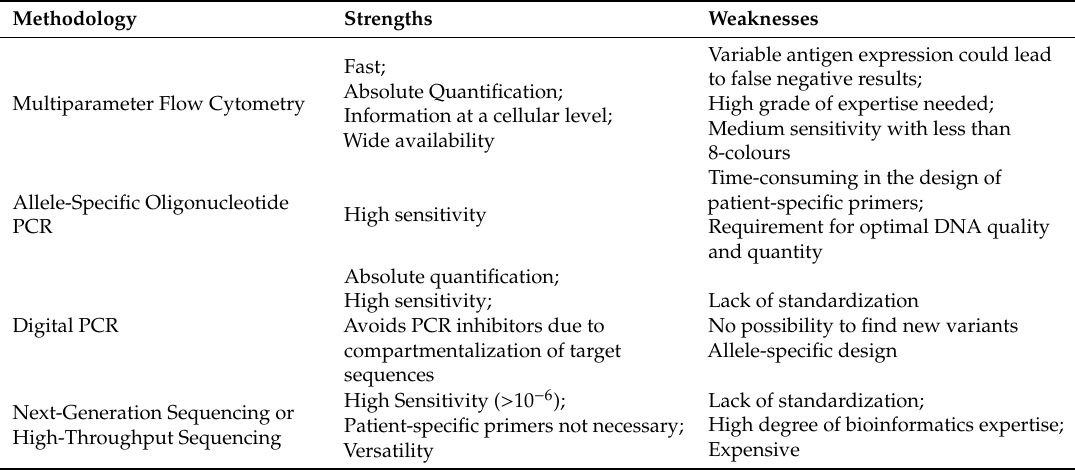
Table 1. Summary of advantages and disadvantages for measuring minimal residual disease (MRD) with the available